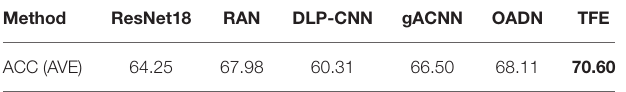
TABLE 3 | Test set accuracy on FED-RO